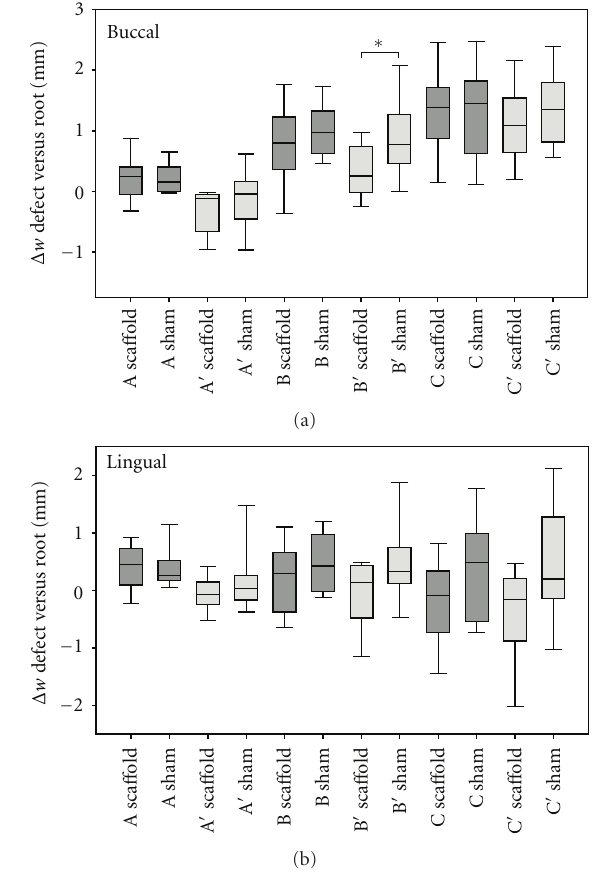
Figure 6: Box plot showing the medians and distributions of di ff erence in buccal and lingual alveolar wall ( A – C ) and total bone thickness ( A (cid:3) , C (cid:3) ) in comparison to equivalent measurement on the corresponding mesial root of each defect site 1mm ( A ), 3mm ( B ), and 5 mm ( C ) apical of the buccal and lingual bone crest ( Δ w = defect − root). The whiskers of the plot represent the 5th and 95th percentiles, ∗ statistically significant di ff erence in this parameter ( P < 0 . 05), n =